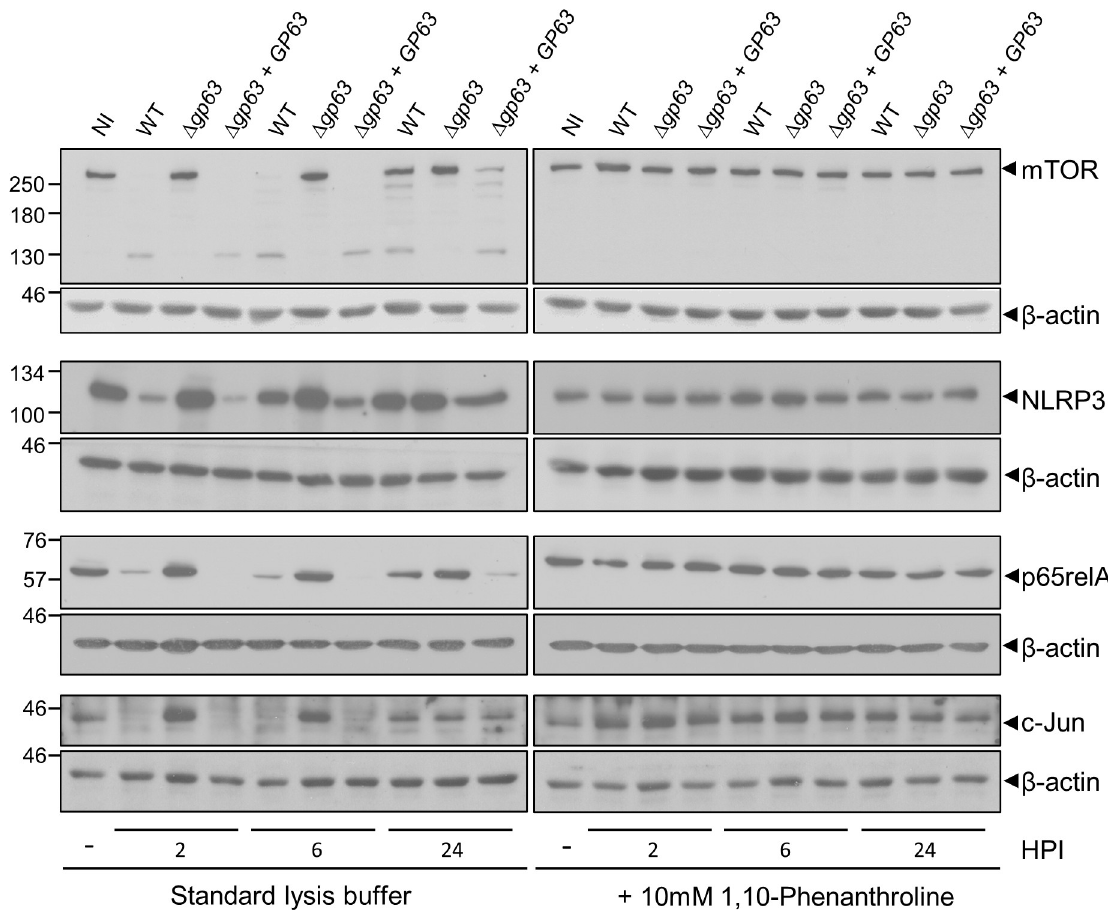
Fig 2. Degradation of mTOR, NLRP3, p65Rel, and c-Jun is prevented when GP63 activity is inhibited during cell lysate preparation. Lysates of uninfected BMM (0 h post-infection) or BMM infected with either WT, Δ gp63 , or Δ gp63 + GP63 L . major metacyclic promastigotes were prepared at the indicated time points in standard lysis buffer or in lysis buffer containing 10 mM 1,10-phenanthroline. Levels and integrity of mTOR, NLRP3, p65RelA, and c-Jun were assessed by Western blot analysis. β -actin was used a loading control. Immunoblots shown are representative of at least four independent experiments. NI, non-infected BMM; HPI, hours post-infection.